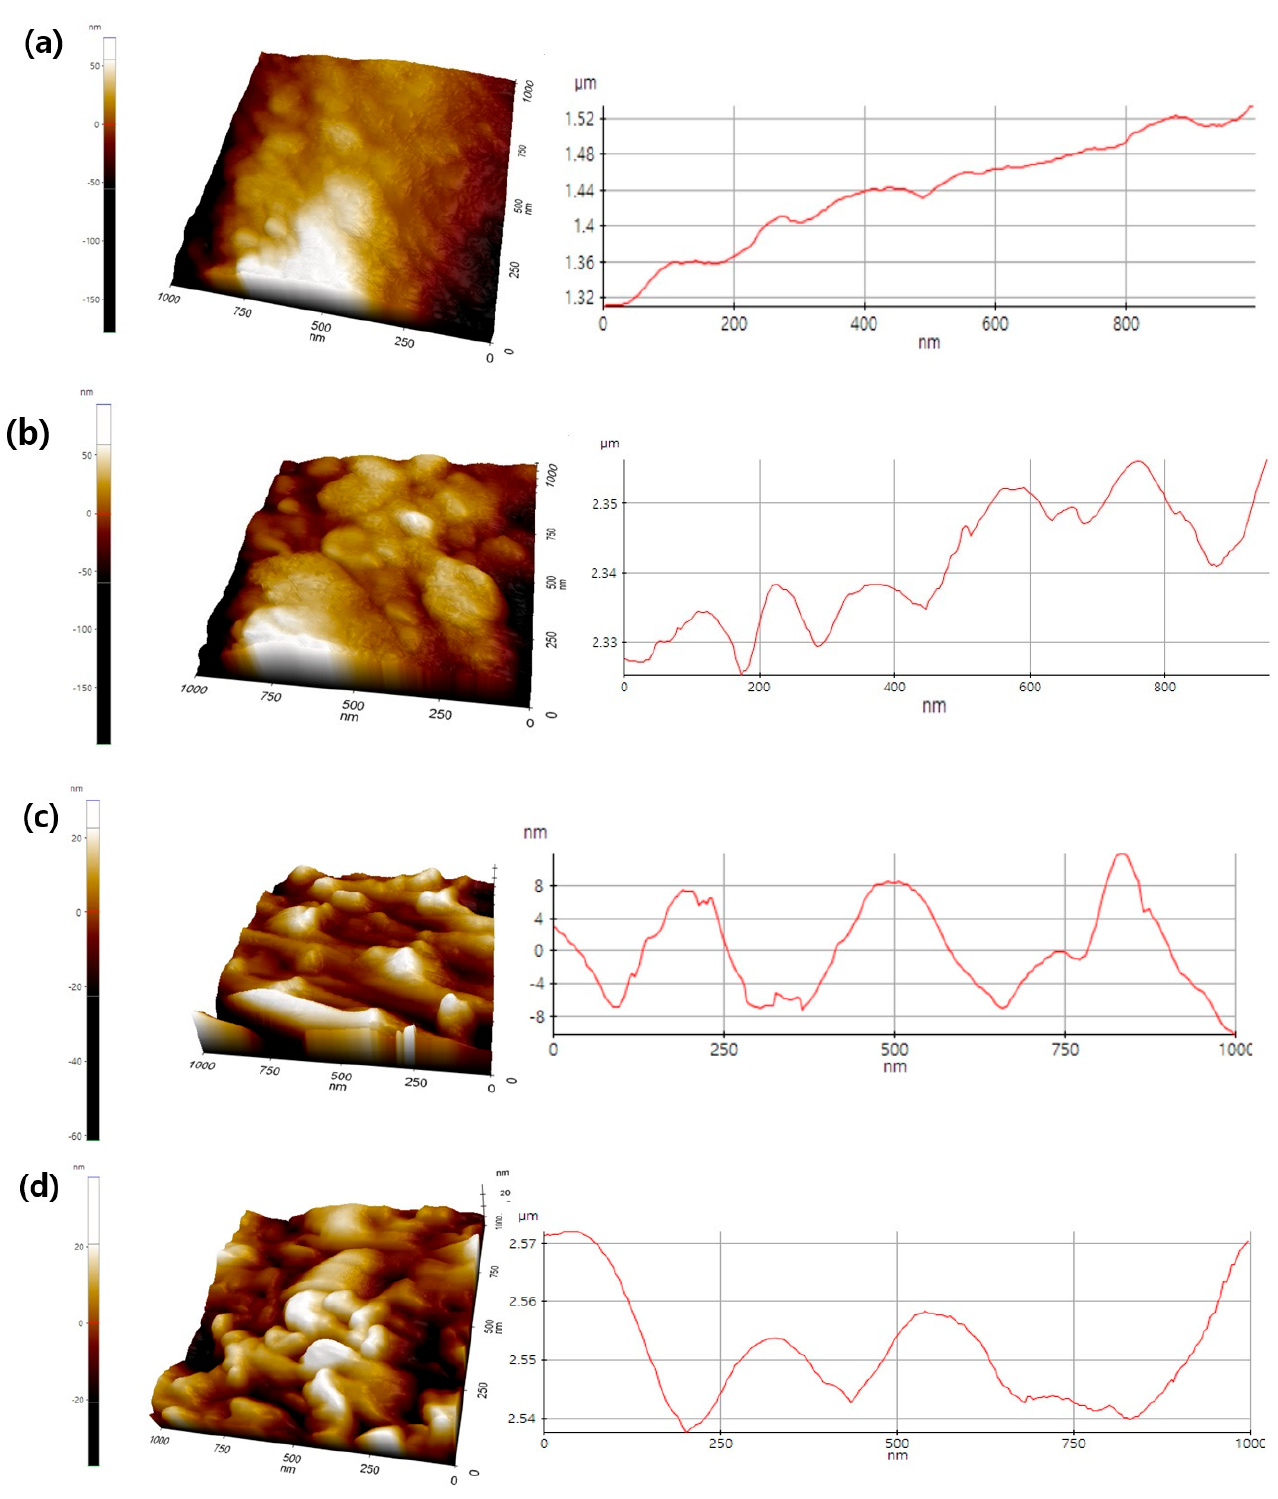
Figure 4. AFM images of PLA fibers; ( a ) non-porous PLA, ( b ) 5:5, ( c ) 6:4, and ( d ) 7:3 PLA.